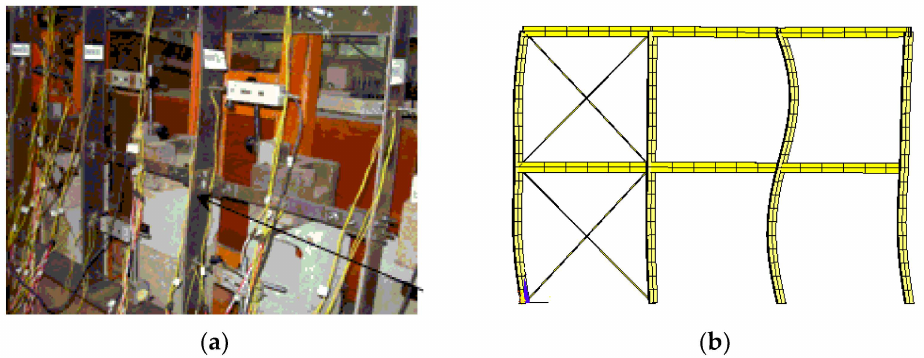
Figure 2. Instability deformation obtained from the tests and FE analyses of Group 2. ( a ) Tests; ( b ) FE analyses.